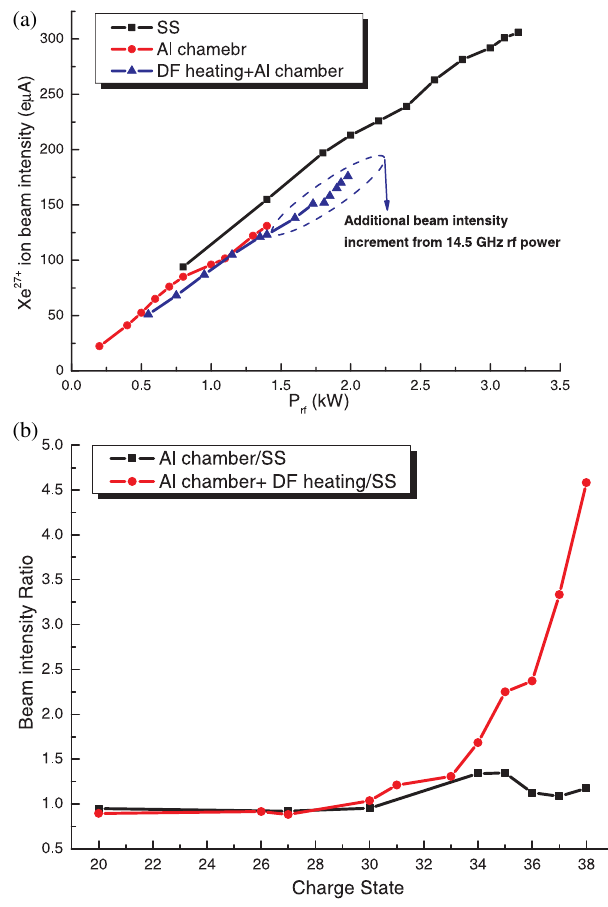
FIG. 13. Xenon beam intensity study with different chamber and microwave power. (a) 129 Xe 27 þ beam intensity evolution as a function of microwave power and comparison among stainless steel (SS) chamber at 18 GHz, aluminum (Al) chamber at 18 GHz, and aluminum chamber at 18 þ 14 . 5 GHz. (b) Xenon beam intensity enhancement with aluminum chamber at 18 þ 14 . 5 GHz double frequency